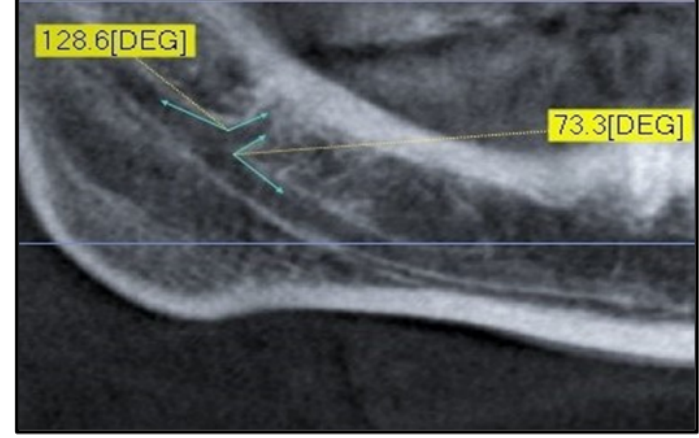
Figure 4. Angle measurement of a Type 1 canal.